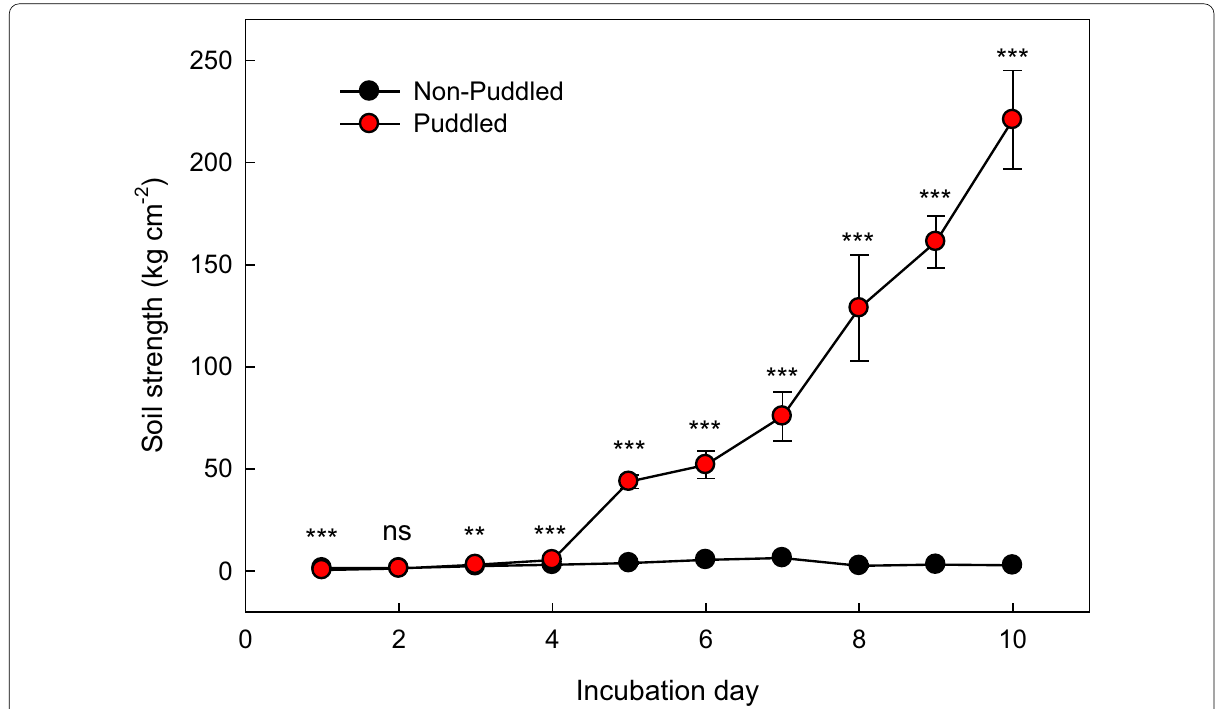
Fig. 6 Soil strength development of the experimental area. Vertical bars indicate standard deviations ( n